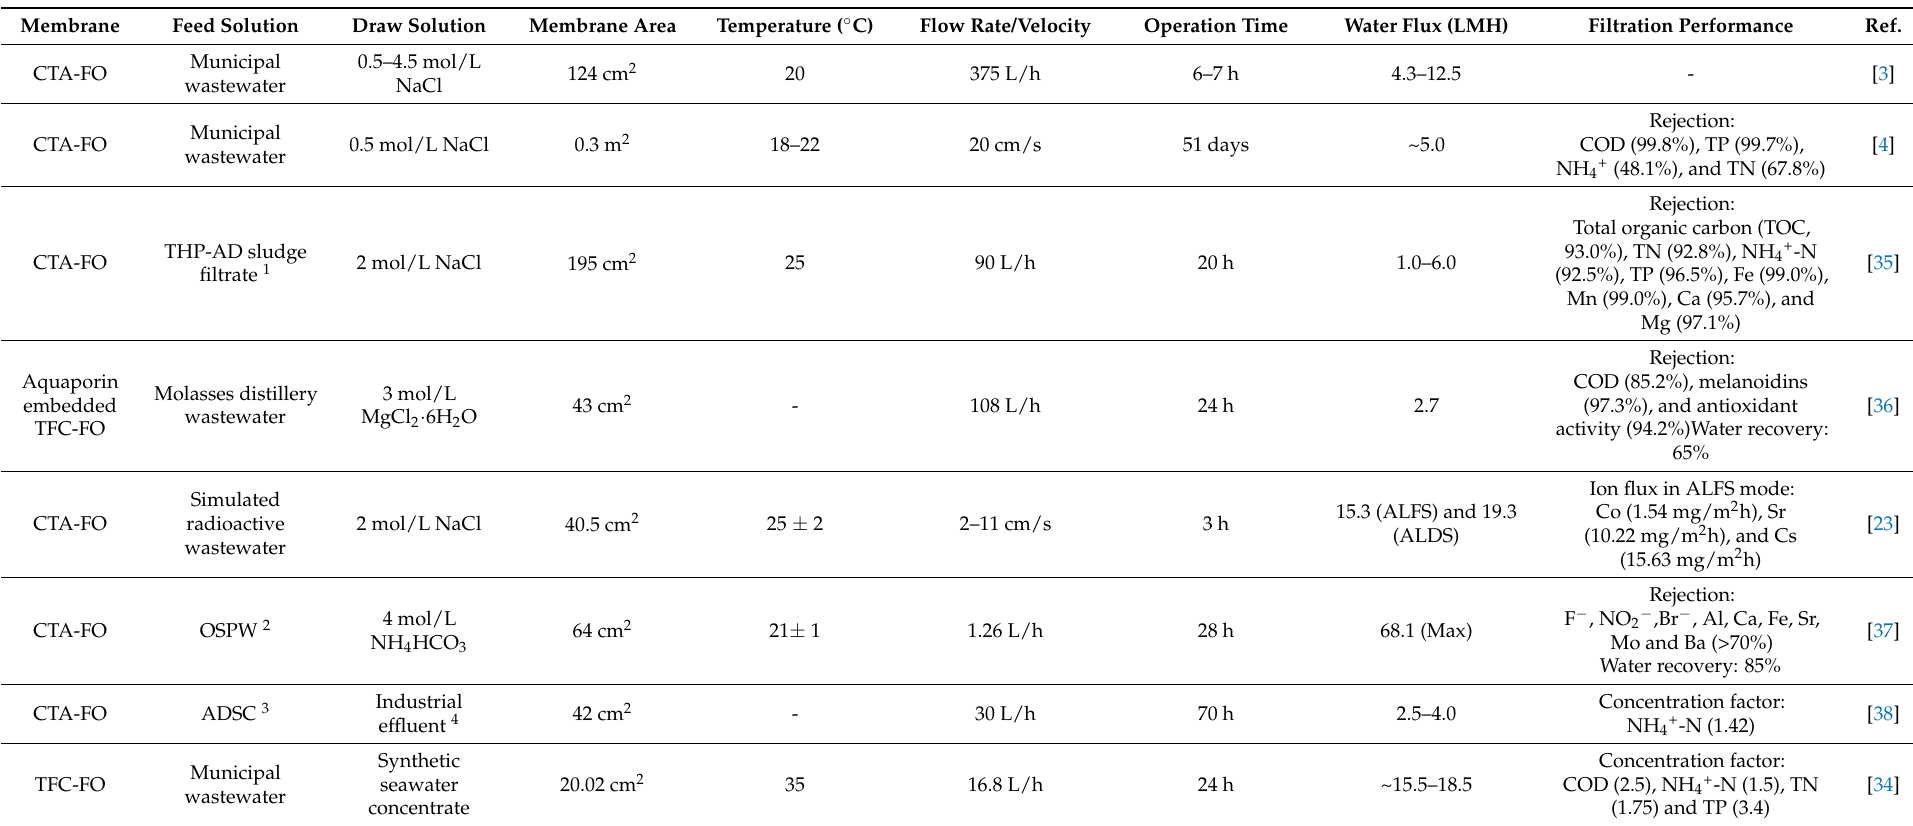
Table 1. Application of the FO process as a single treatment process for sewage concentration and wastewater